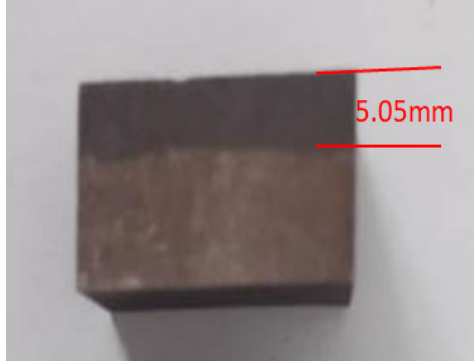
Figure 7. Coating thickness test.